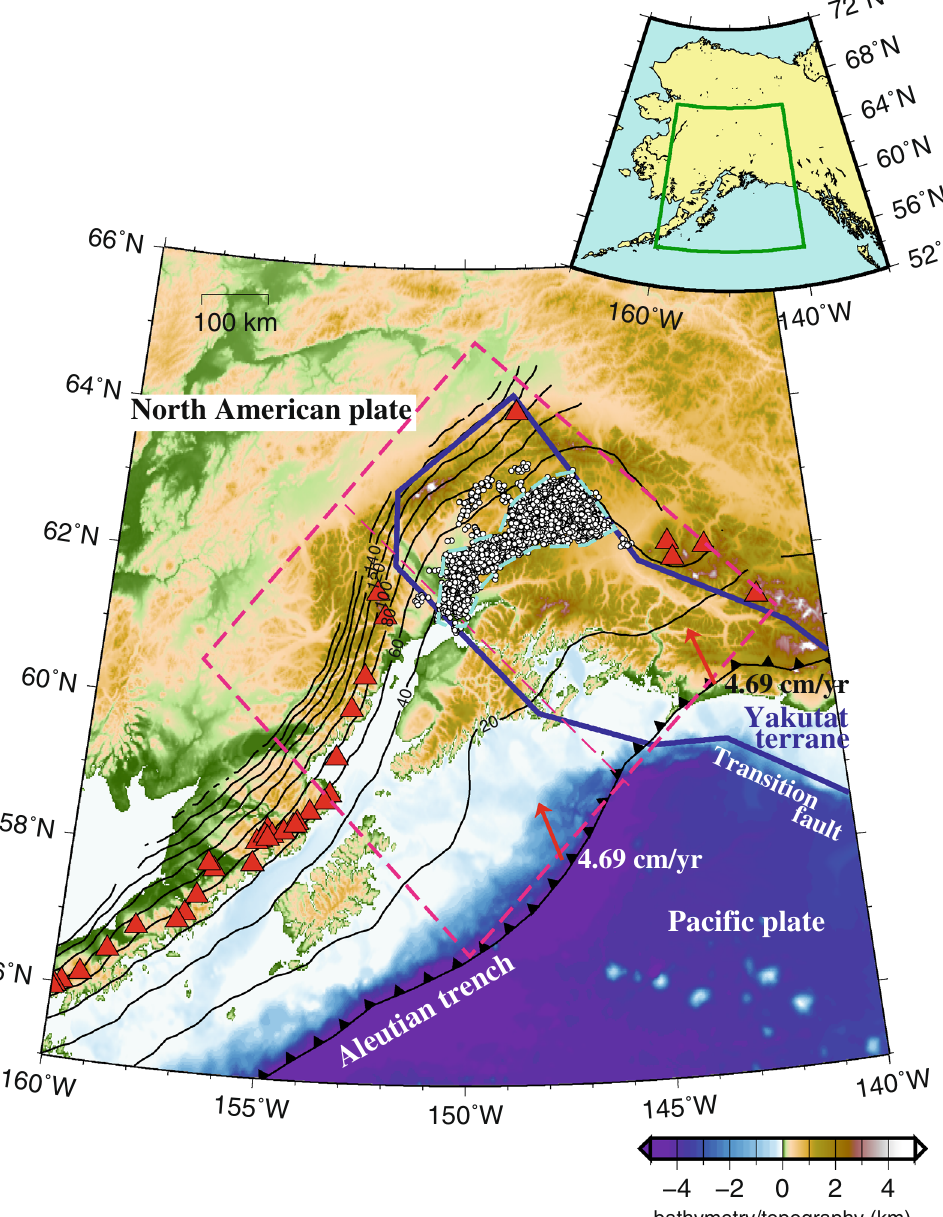
Figure 1. Tectonic map of the Alaska subduction zone. The tectonic map shows the area within the solid green box in the inset. The thick blue solid line represents the Yakutat terrane 1 . The white circle indicates the epicentre 6 of tectonic tremors, and the light blue dashed line indicates the tectonic tremor occurrence area used in Figs. 2, 3, 4, and 5. The thick barbed black line indicates the Aleutian Trench, the thin black lines indicate the isodepth contours of the upper surface of the subducted oceanic plate by Slab 2 26 with a contour interval of 20 km, and the red triangles indicate volcanoes. Red arrows represent the current (0 Ma) subduction direction of the oceanic plate at the trench calculated from Matthews et al. 27 . The pink dashed box is the model region in this study, and the pink dashed line in the centre dividing the model region into the northeast and southwest sides represents the boundary between the subducted Yakutat terrane and the subducted Pacific plate in our model. The map was created by using the Generic Mapping Tools (GMT) 25 (version: GMT 4.5.7, URL link: https:// www. gener ic- mappi ng- tools. org/ downl